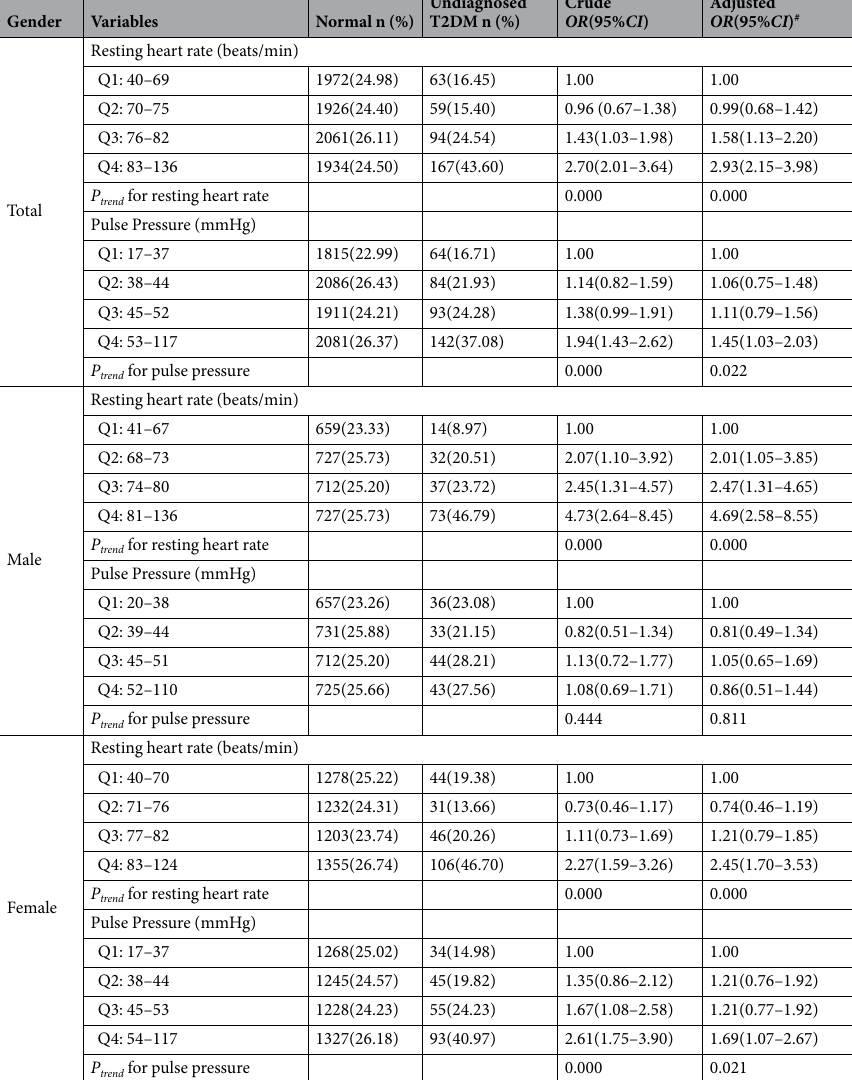
Table 2. Analyses for the risk of undiagnosed T2DM according to the resting heart rate and pulse pressure (n = 8276). # Adjusted for age (years), sex, smoking, drinking, education, physical activity, marital status, intakes of vegetables and fruits, high–fat diet, family history of diabetes and BMI (kg/m 2